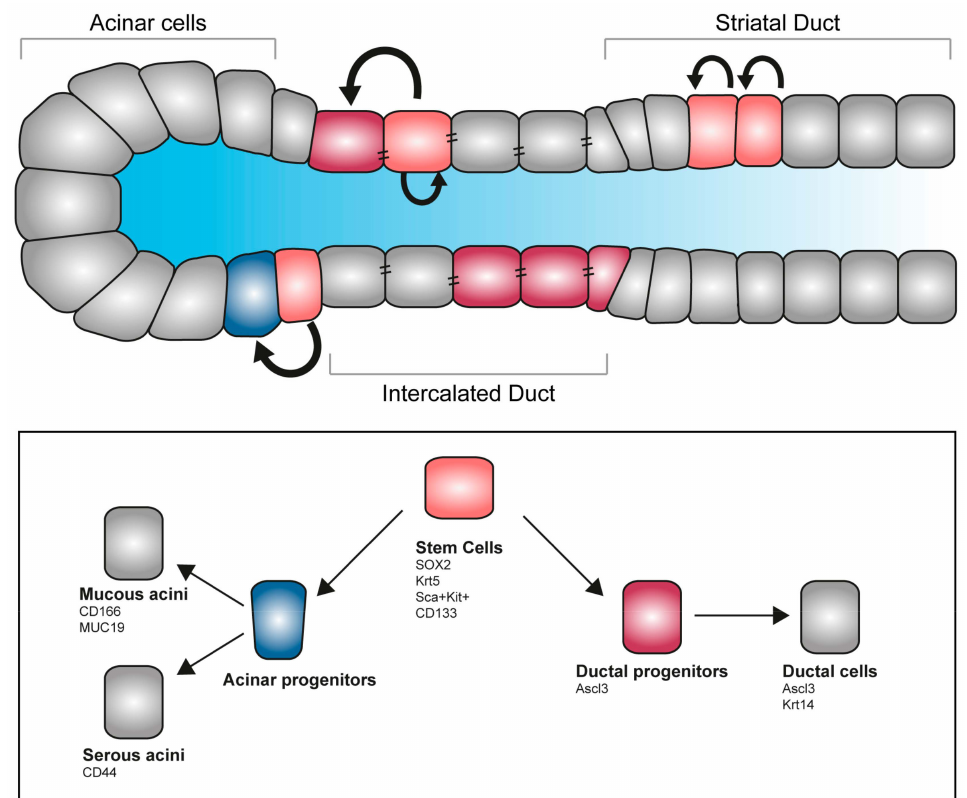
Figure 4. Stem cell pool and regeneration of salivary glands. Salivary glands contain several pools of undi ff erentiated progenitors able to self-renew, proliferate and give rise to di ff erentiated acinar and ductal cells. Several markers allow the identification of stem cells and committed progenitors, allowing fate tracking and molecular